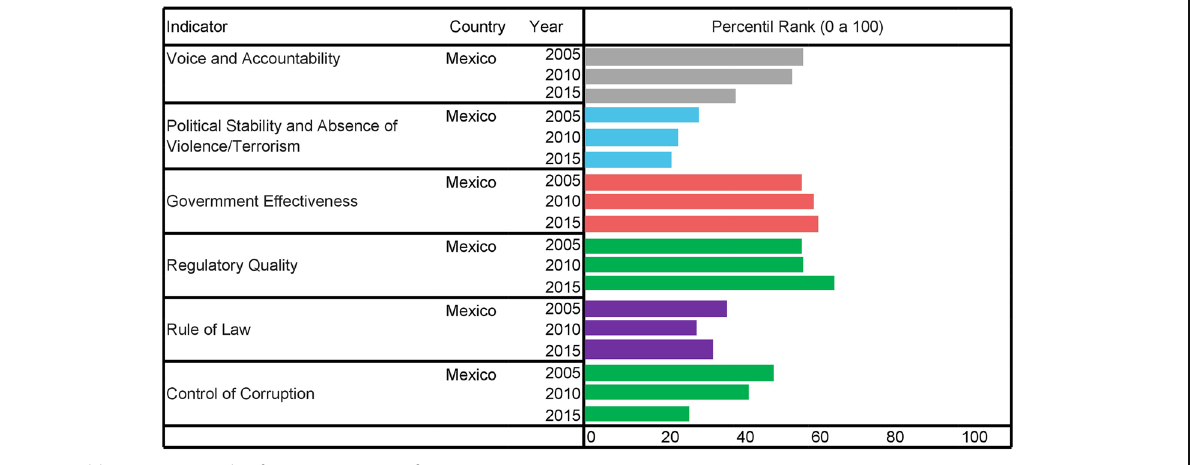
Fig. 1 World governance index from 2005 to 2015 for Mexico. Source: